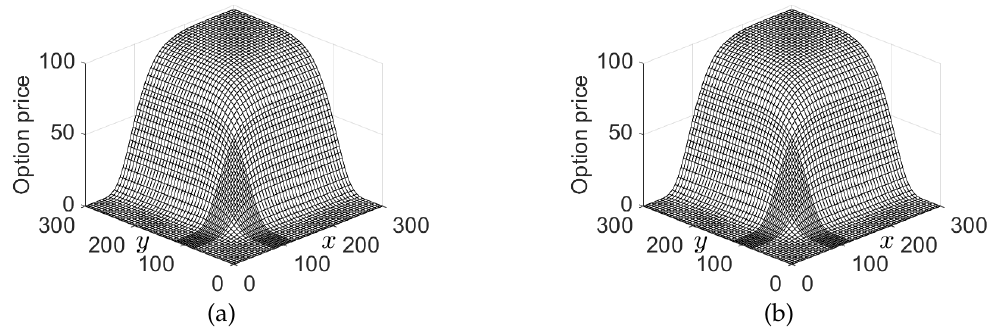
Figure 3. Closed-form and numerical solutions of cash-or-nothing option with Ω 3 × Ω 3 : ( a ) closed-form solution and ( b ) numerical